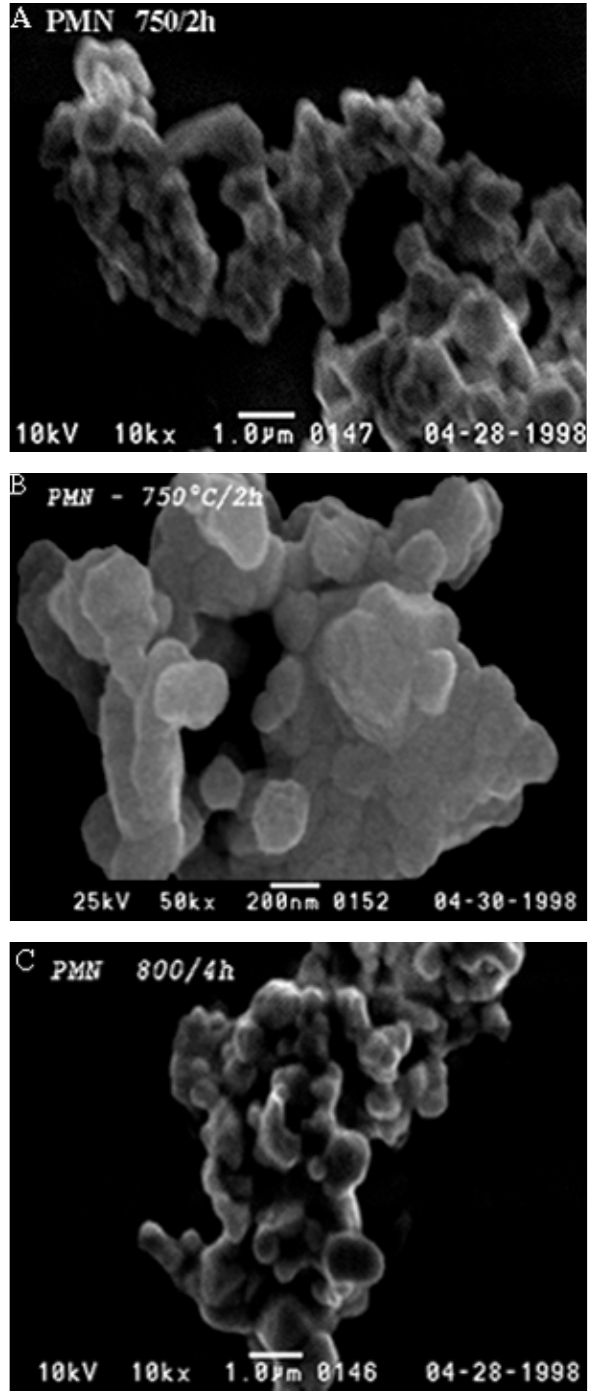
Figure 8. SEM micrographs for PMN samples: a) Route 1-750 °C/2 h, b) Route 2-750 °C/2 h, c) Route 2-800 °C/4 phase. A PMN powder with about 100% of perovskite phase was obtained using route 2 after calcining at 800 °C for 4 h, as observed in Fig. 7. Free-pyrochlore PMN ob- tained in large range calcination conditions showed that method (route 2) is more efficient than oxide mixture 20 .